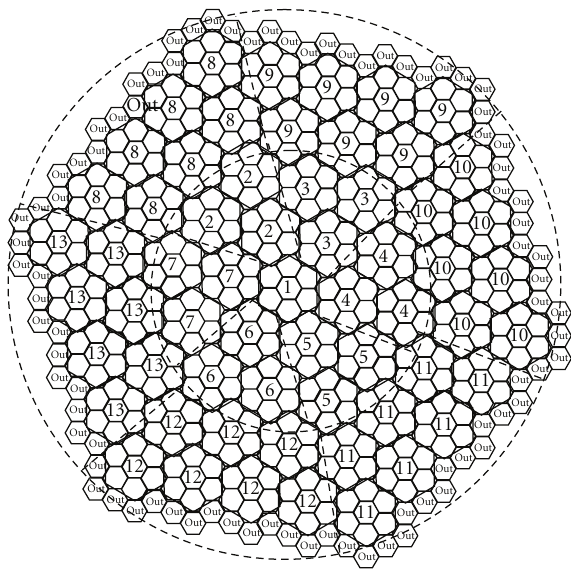
Figure 11: Example of paging area topology with 13 paging area a j , j = 1, ... ,13. Base stations are located in hexagons with labelled numbers (Paging Area ID). Relay stations are located in hexagons without